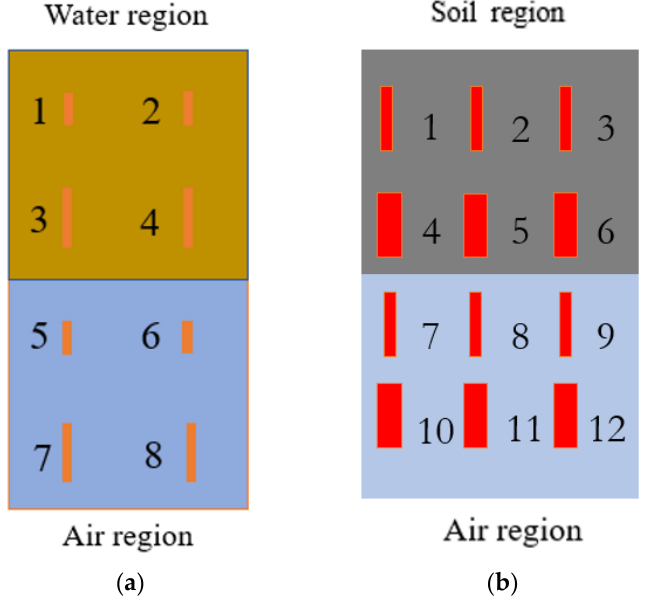
Figure 4. Distribution of defects in the membrane (plan view): ( a ) defects in contact with water and air; ( b ) defects in contact with soil and air. Table 5. Dimensional details for defects shown in Figure 4a.